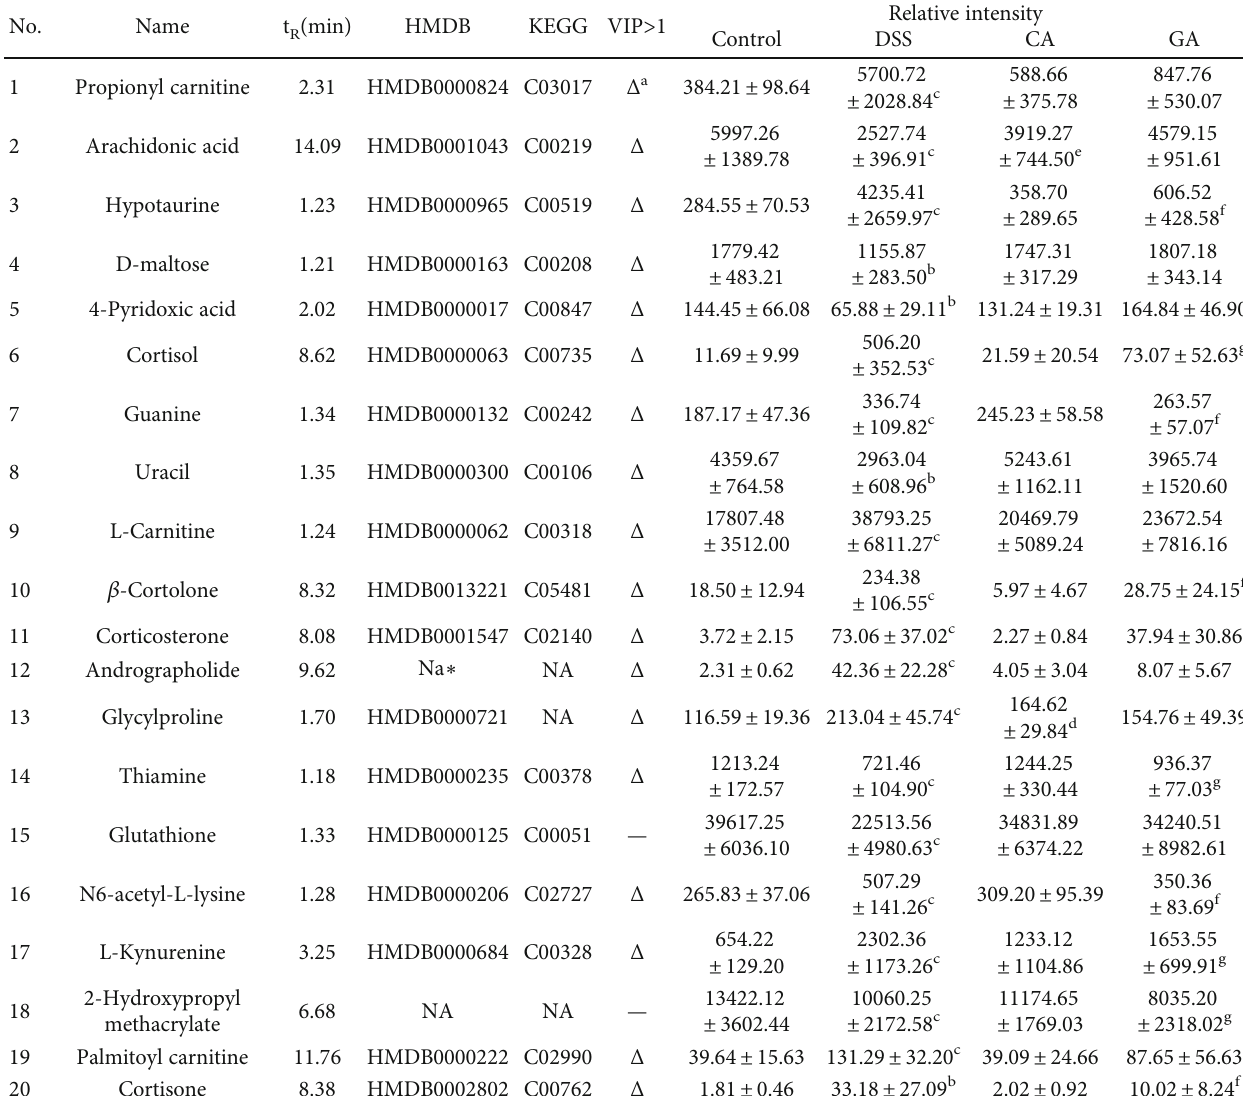
Table 1: The twenty signi fi cant metabolites in liver of control group, DSS group, CA group, and GA group.